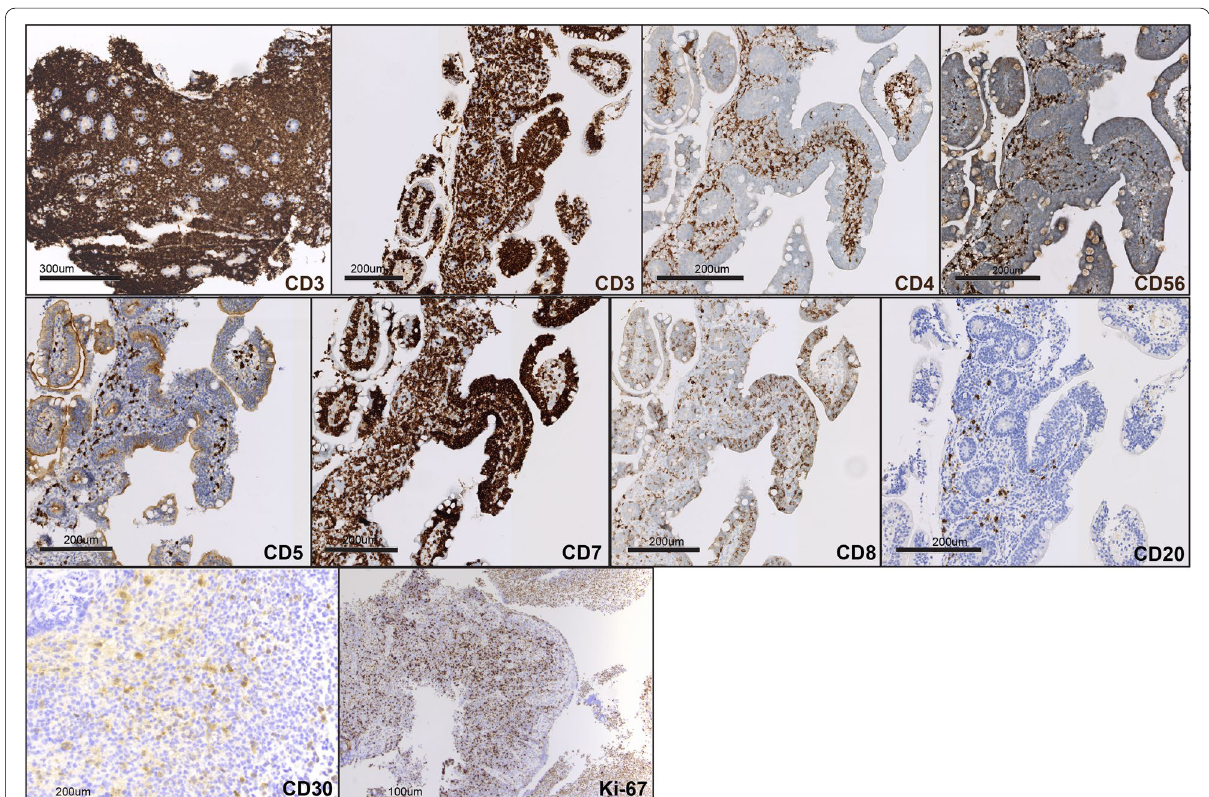
Fig. 3 Immunohistochemical characterization of the atypical lymphocytic infiltrates. Each of the immunostains analyzed is indicated in the corresponding